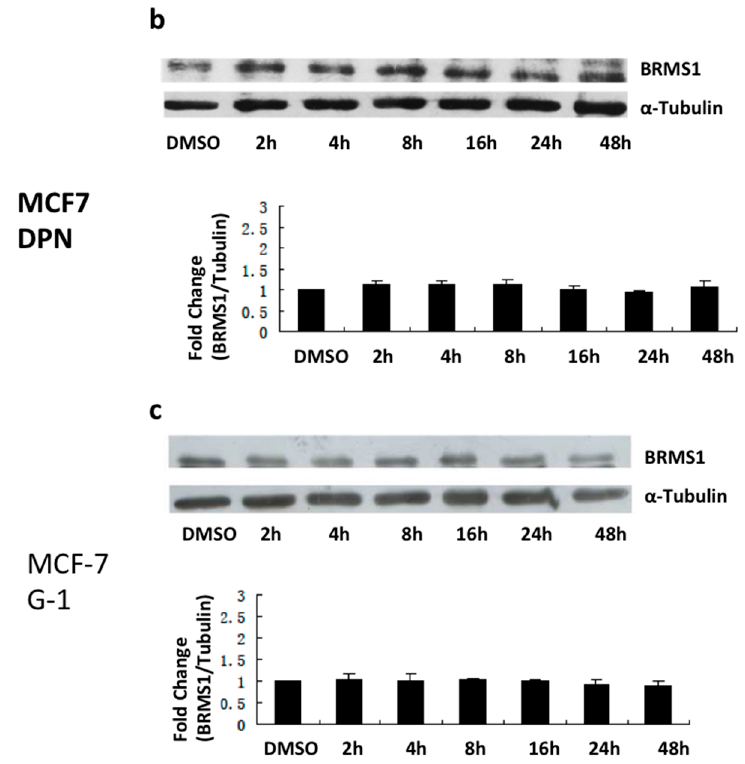
Figure 4. Western blot results of PPT, DPN and G-1 effects on induction of BRMS1 protein expression in MCF-7 cells. MCF7 cells were incubated with culture media containing ( a ) 10 nM PPT; ( b ) 10 nM DPN or ( c ) 100 nM G-1 for 2, 4, 8, 16, 24 and 48 h. Control cells were incubated with culture media containing 10 nM DMSO ( a , b ) or 100 nM ( c ) for 2 h. Proteins were quantitated as previously described. Graphs and error bars represent the average of three independent experiments ± SD. * indicates statistical significance at the p < 0.05 level compared to DMSO.